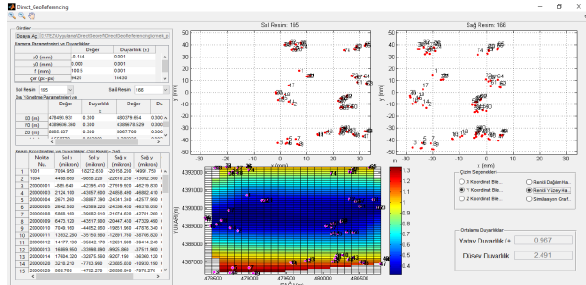
Figure 1. Application interface.